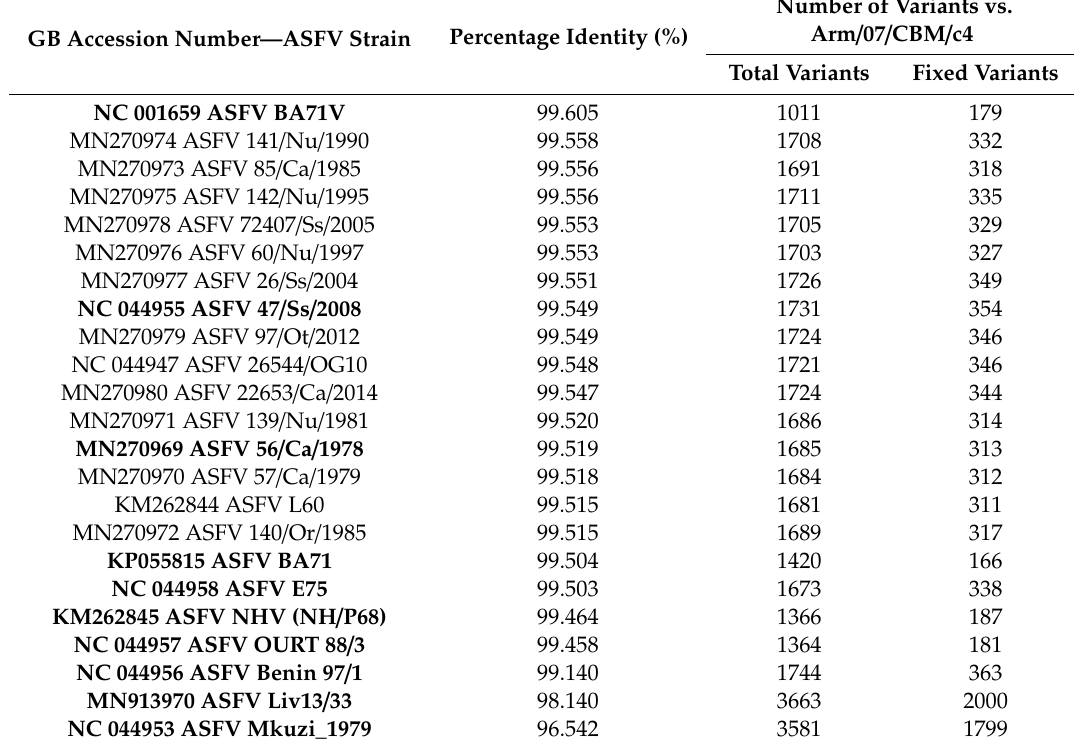
Table 8. Percentage identity between ASFV Arm / 07 / CBM / c4 strain and di ff erent genotype I ASFV strains and number of total and fixed